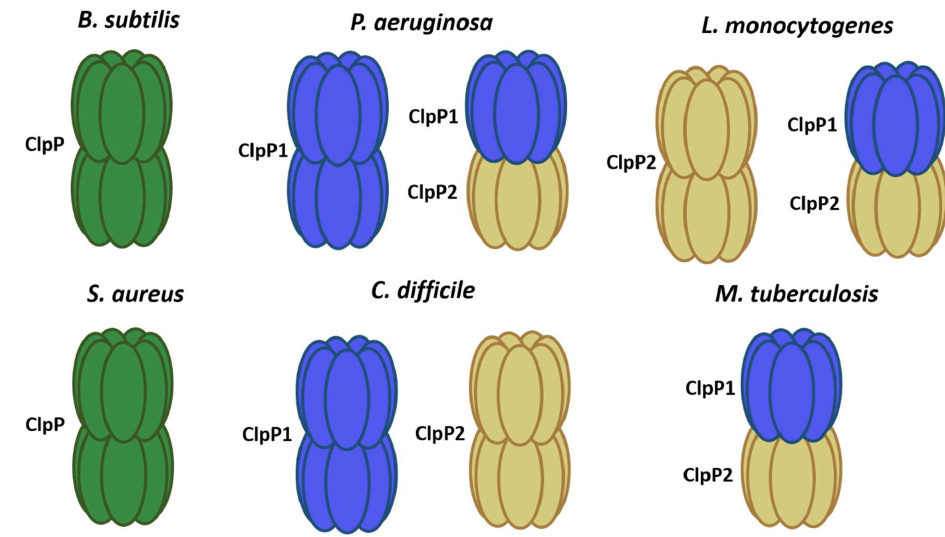
Figure 1. ClpP models in different bacteria. In green, it shows single ClpP peptidases forming 2 rings ( B. subtilis and S. aureus ). ClpP1 subunit in blue and ClpP2 in yellow.